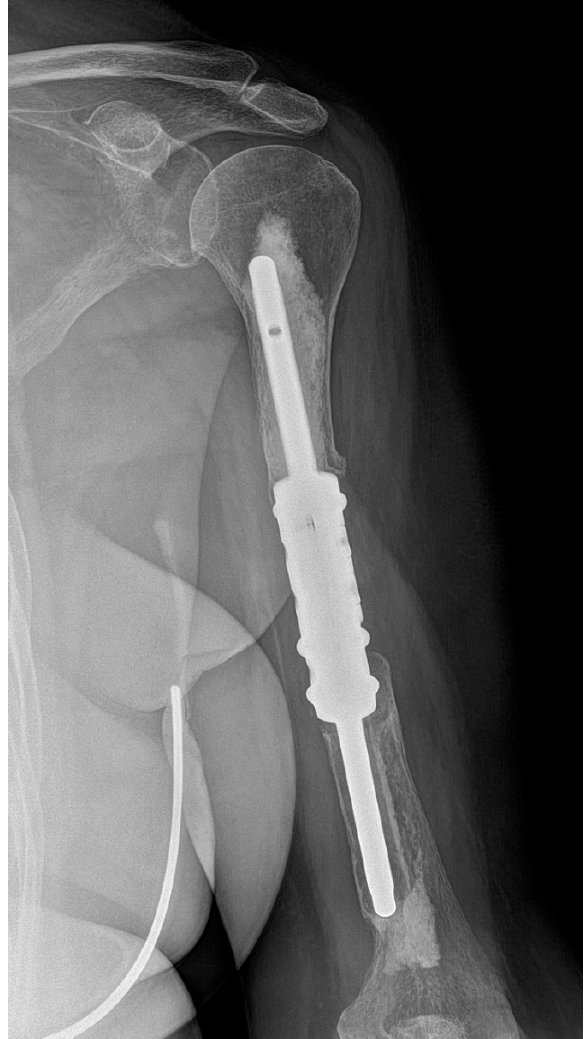
Figure 3. X-ray image of aseptic loosening of the distal stem of the humeral intercalary endoprosthesis. Resection of the metastasis revealed it was a uterine sarcoma solitary metastatic lesion of the left humerus. After 23 months, there was aseptic loosening. Due to the patient’s poor general condition (pulmonary and multiple skeletal metastases) and acceptable functional result (a Musculoskeletal Tumor Society score of 21), revision was not indicated. This image is from patient 7 in Table